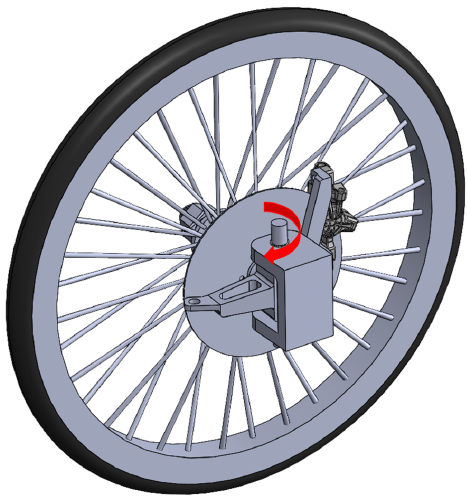
Figure 4. Schematic diagram of the front wheel steering assembly.